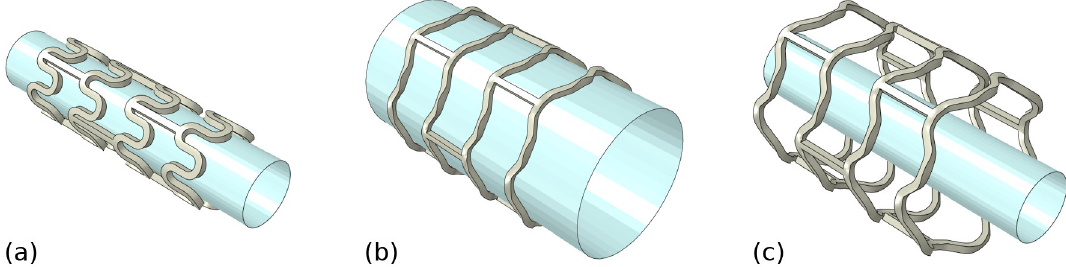
Fig 4. Finite element deployment simulation showing the stent in its (a) initial crimped state; (b) deployed (expanded) state and (c) final (recoiled) state.